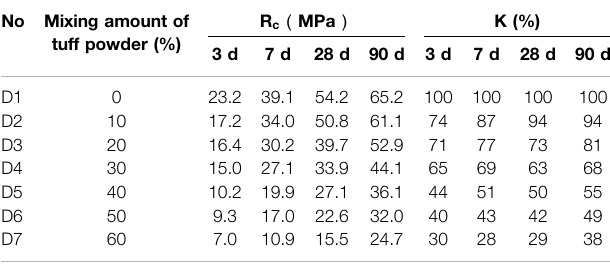
TABLE 3 | Mixture proportion of tuff powder-cement paste.